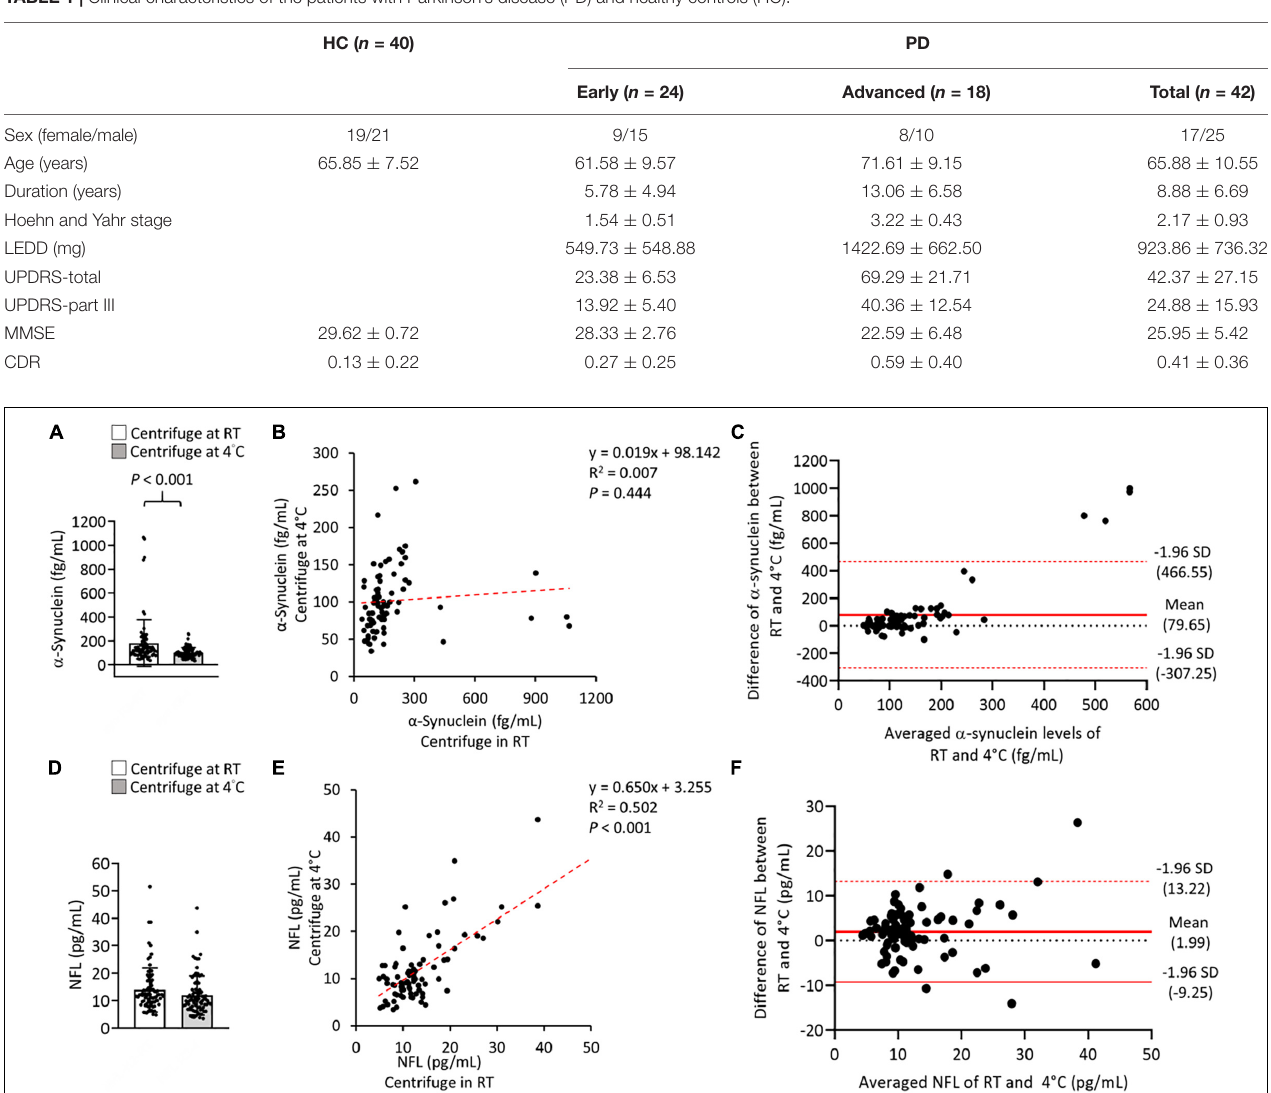
TABLE 1 | Clinical characteristics of the patients with Parkinson’s disease (PD) and healthy controls (HC).